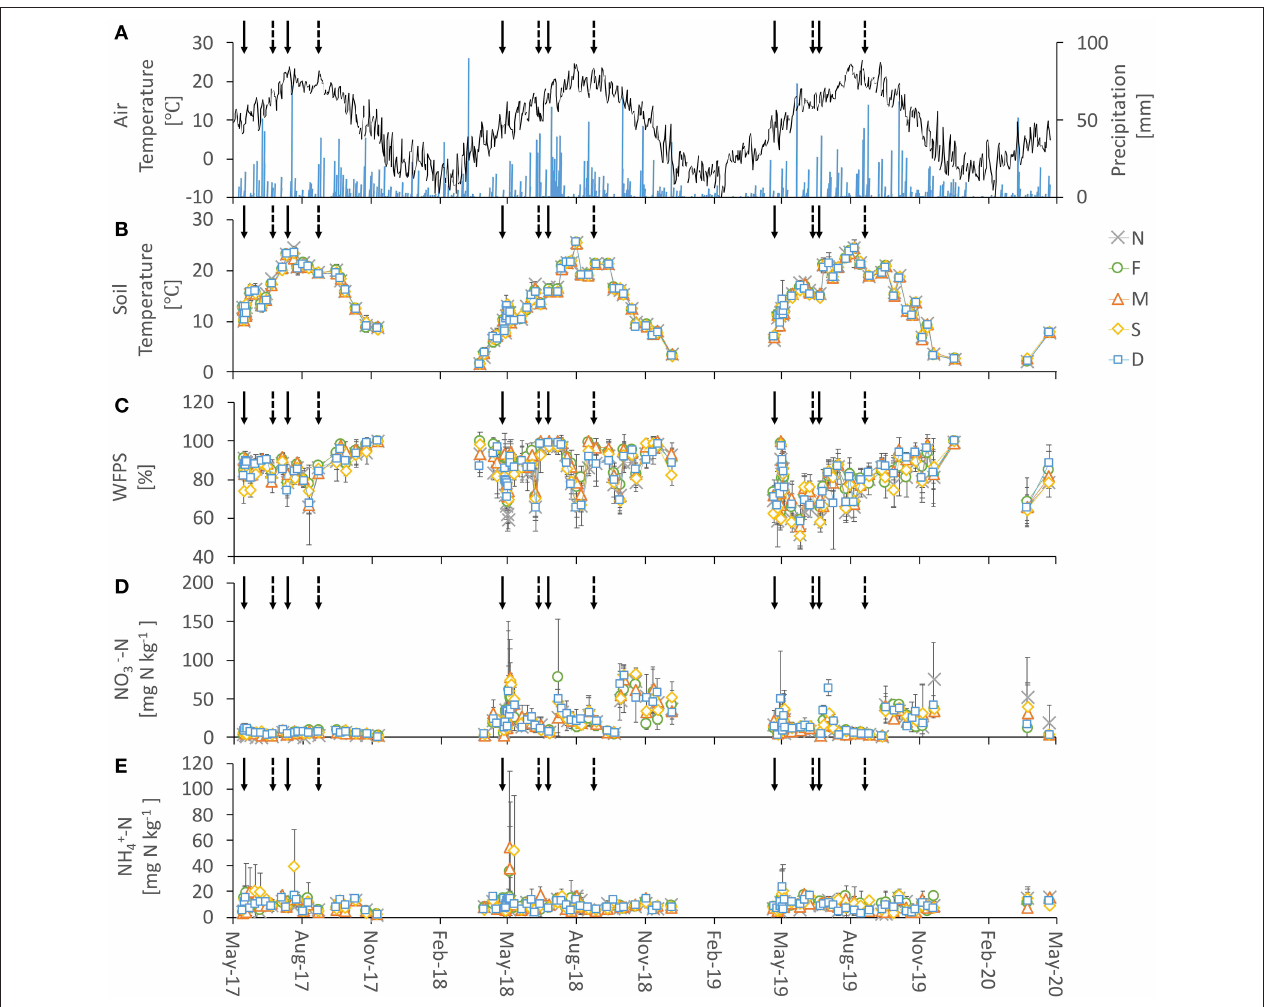
FIGURE 1 | Change in air temperature and precipitation (A) , soil temperature at a depth of 5cm (B) , water filled pore space (WFPS) at the 0–6cm soil depth (C) , soil NO − 3 -N content (D) , soil NH + 4 -N content (E) . Error bars represent standard deviations, solid and broken arrows represent fertilization and harvest, respectively. n = 3.